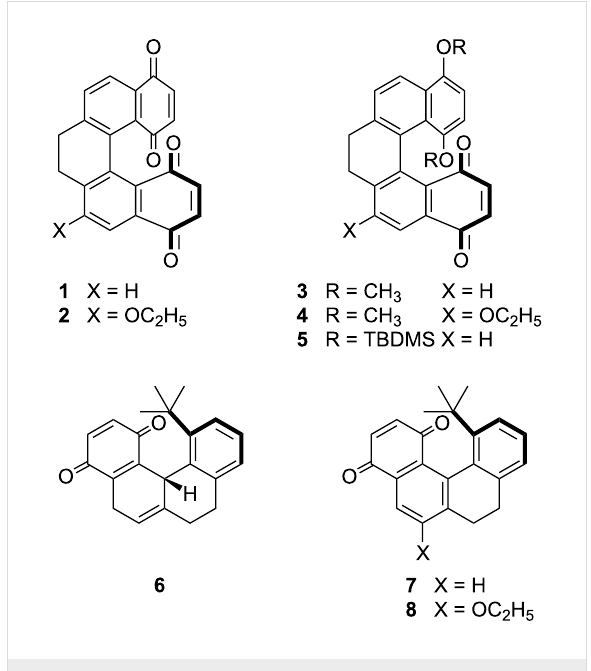
Figure 2: Structures of the dopants investigated.